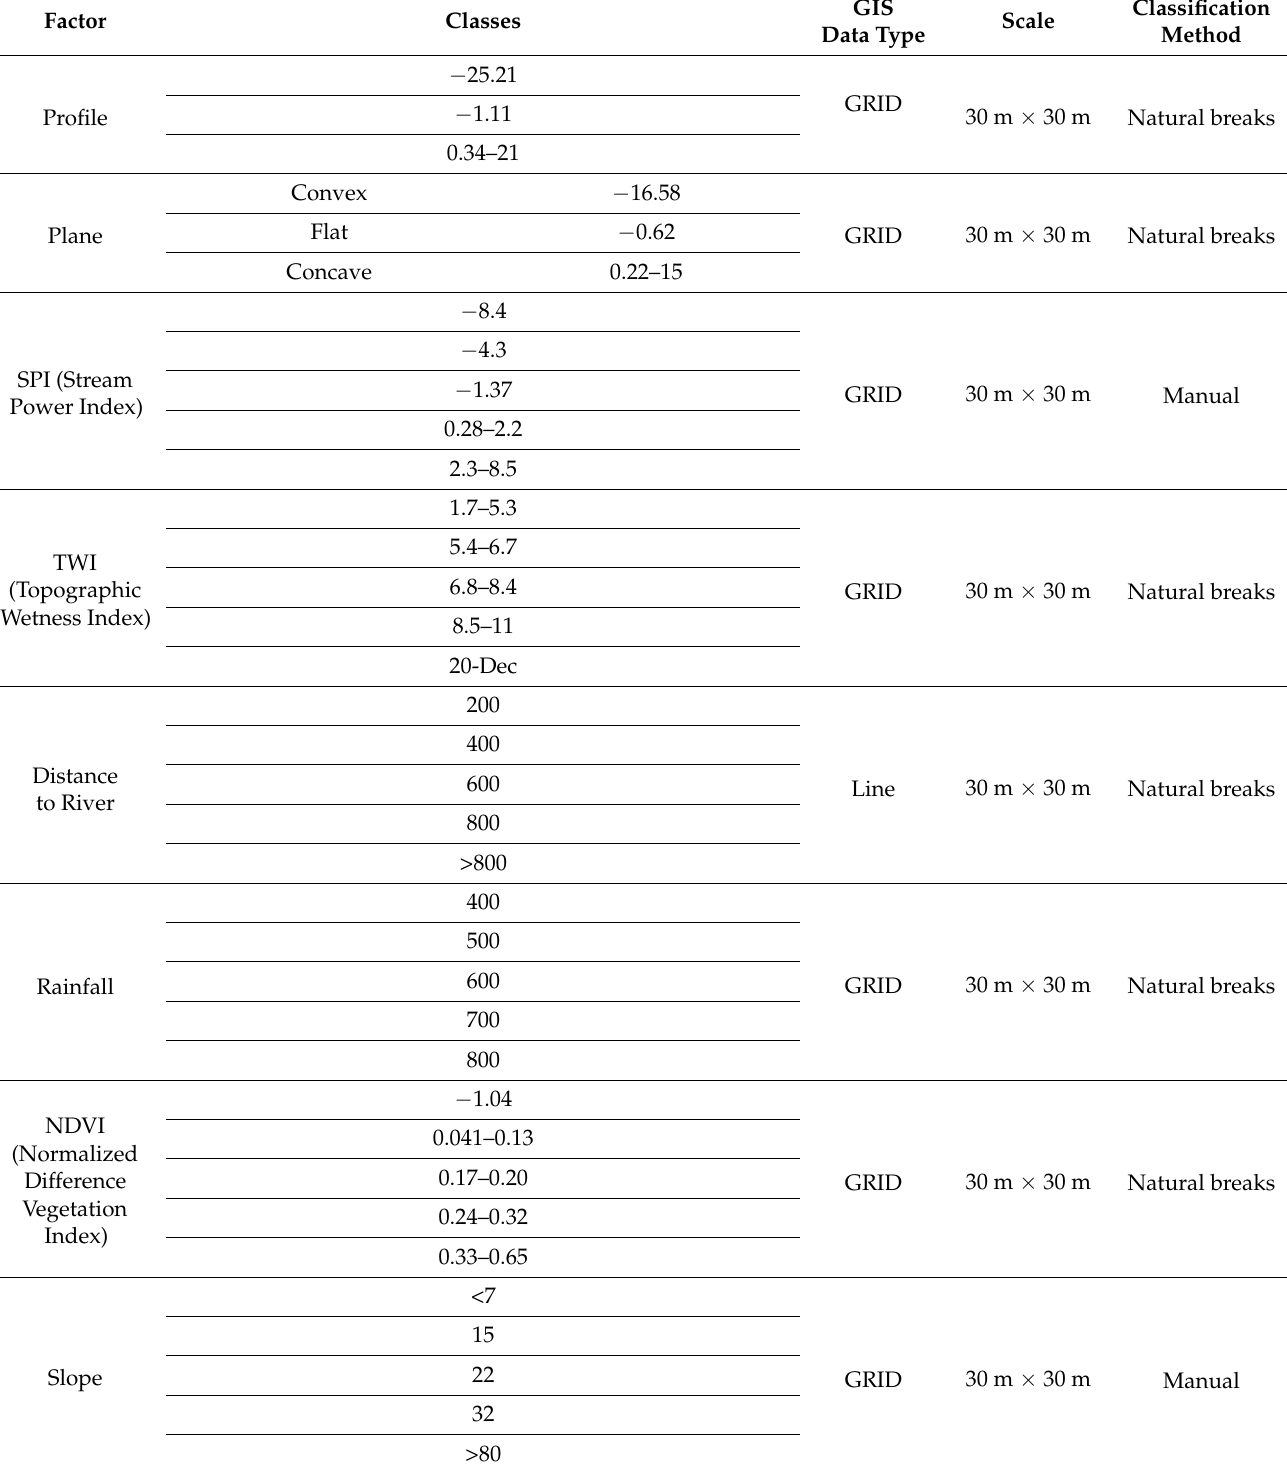
Table 1. Landslide conditioning factors and their